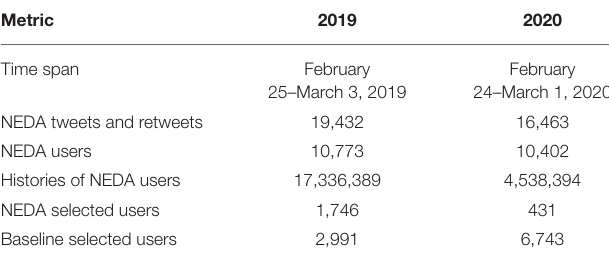
TABLE 1 | Summary statistics of the 2019 and 2020